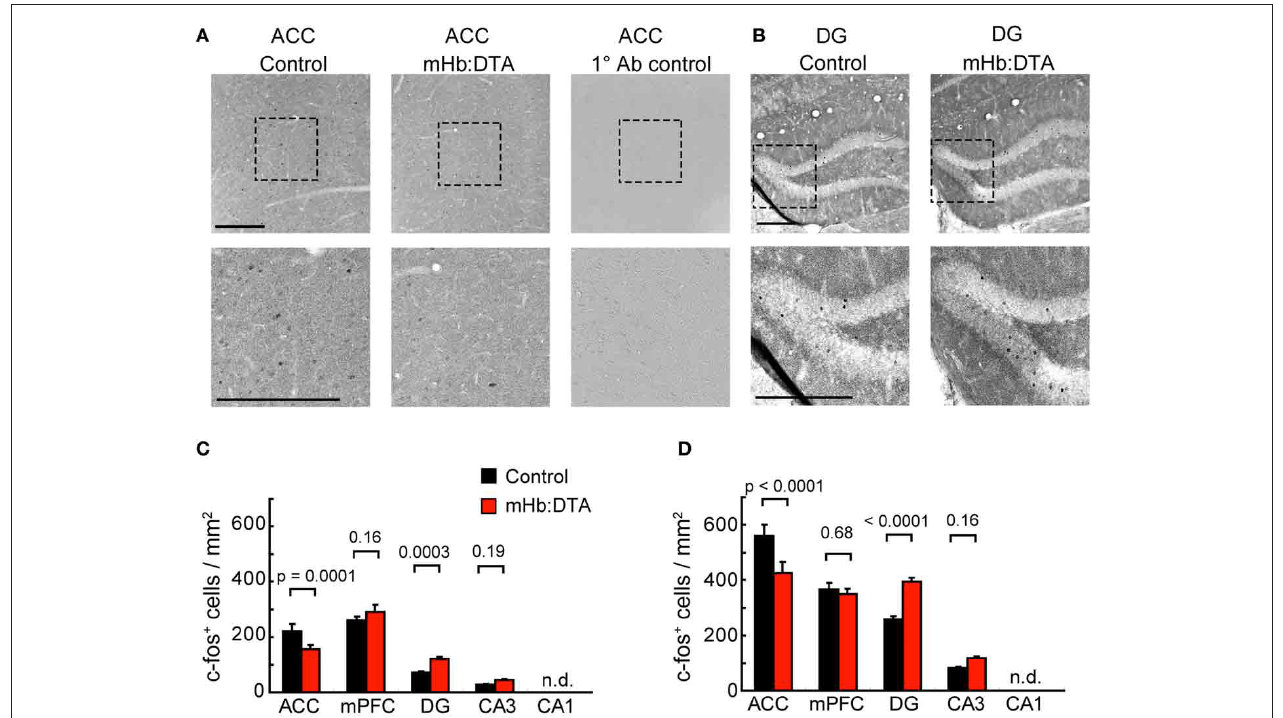
mHb:DTA mice trained was significantly lower in the ACC and higher in the DG and CA3 [ N = 4 mice, n = 16 slices/genotype; Two-Way ANOVA genotype × area interaction, F ( 3 , 280 ) = 10 . 45, P < 0 . 0001]. n.d., not detected. (D) The number of c-Fos-positive cells in mHb:DTA mice exposed to the chamber but not trained was also significantly lower in the ACC and higher in the DG and CA3 [ N = 4 mice, n = 16 slices/genotype; Two-Way ANOVA genotype × area interaction, F ( 3 , 280 ) = 14 . 9 , P < 0 . 0001]. n.d., not detected. P value: Bonferroni post-hoc